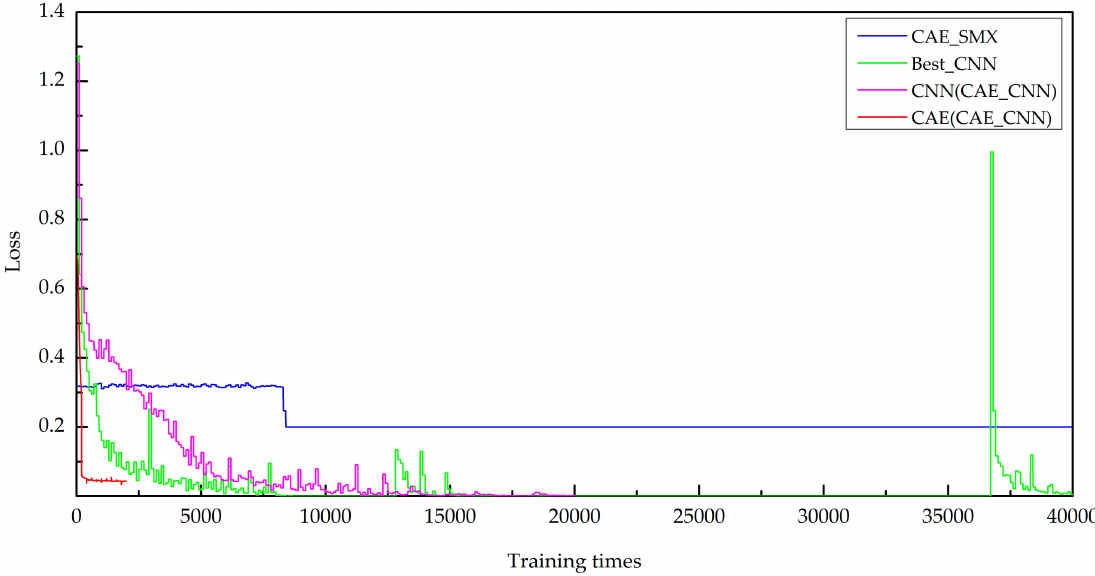
Figure 8. Loss function values during model